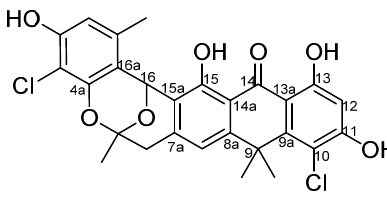
Figure 5. The structure of zunyimycin A.